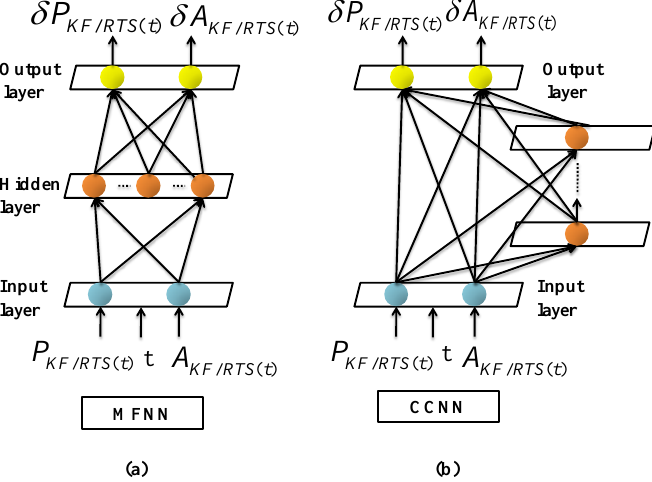
Figure 13 . The comparison between finalized CCNN and MFNN